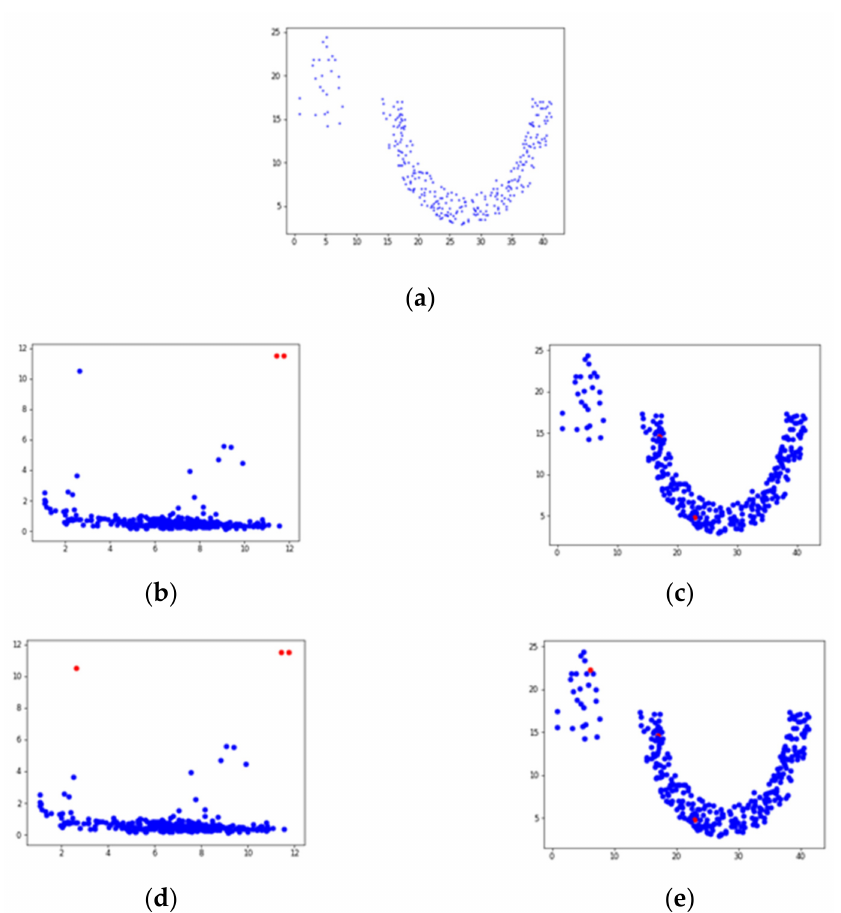
Figure 4. Key points detection of dataset with multiple shapes and densities ( a ) distribution of the dataset; ( b ) two core points are selected; ( c ) the distribution of two core points in the dataset; ( d ) three core points are selected; ( e ) the distribution of three core points in the